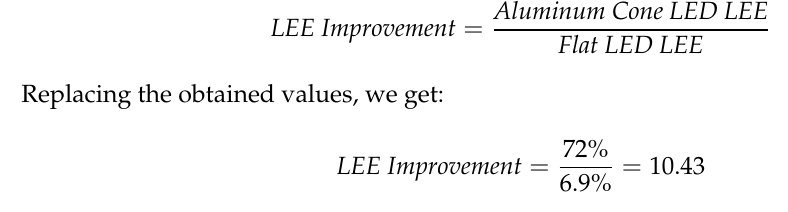
Figure 19. LENS Pixel angular distribution CPC narrowing, LightTools simulation .